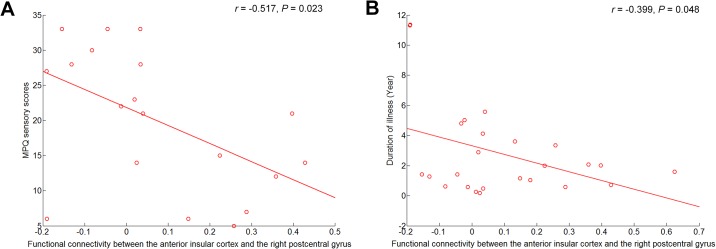
Scatter plots showing the correlations of functional connectivity in the anterior insula and right postcentral gyrus with (A) pain severity and (B) illness duration.Abbreviations: MPQ, McGill Pain Questionnaire.